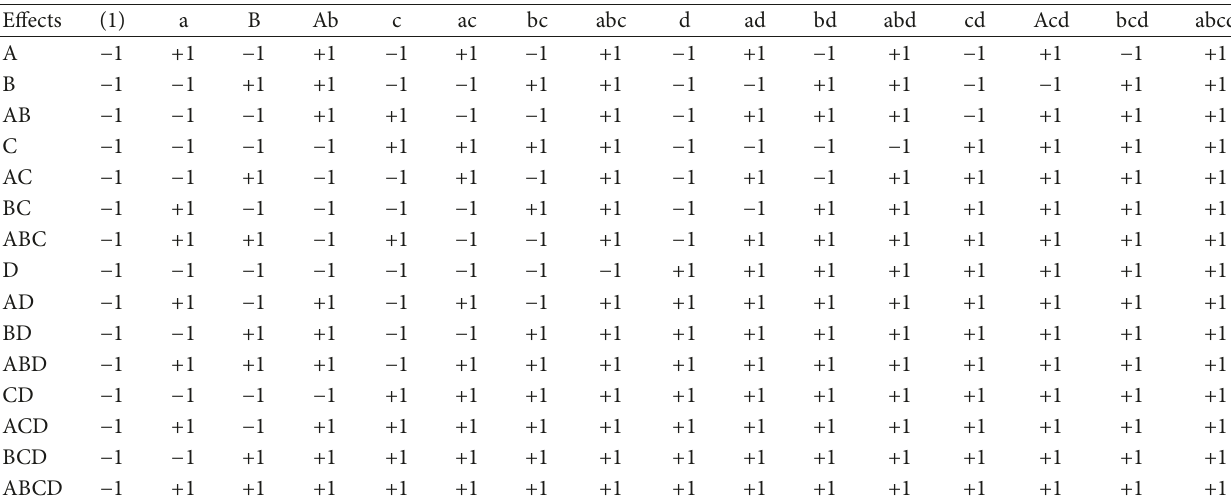
Table 4: Contrast coefficients of